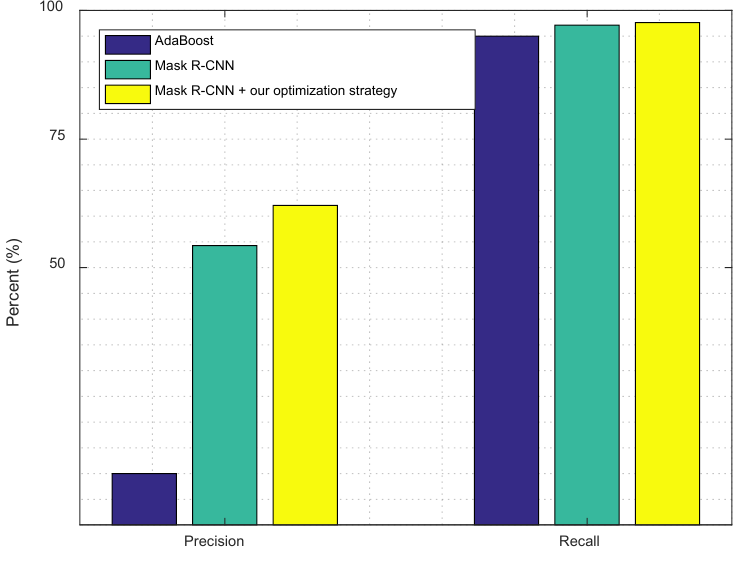
Figure 10. Comparison of the detection results on